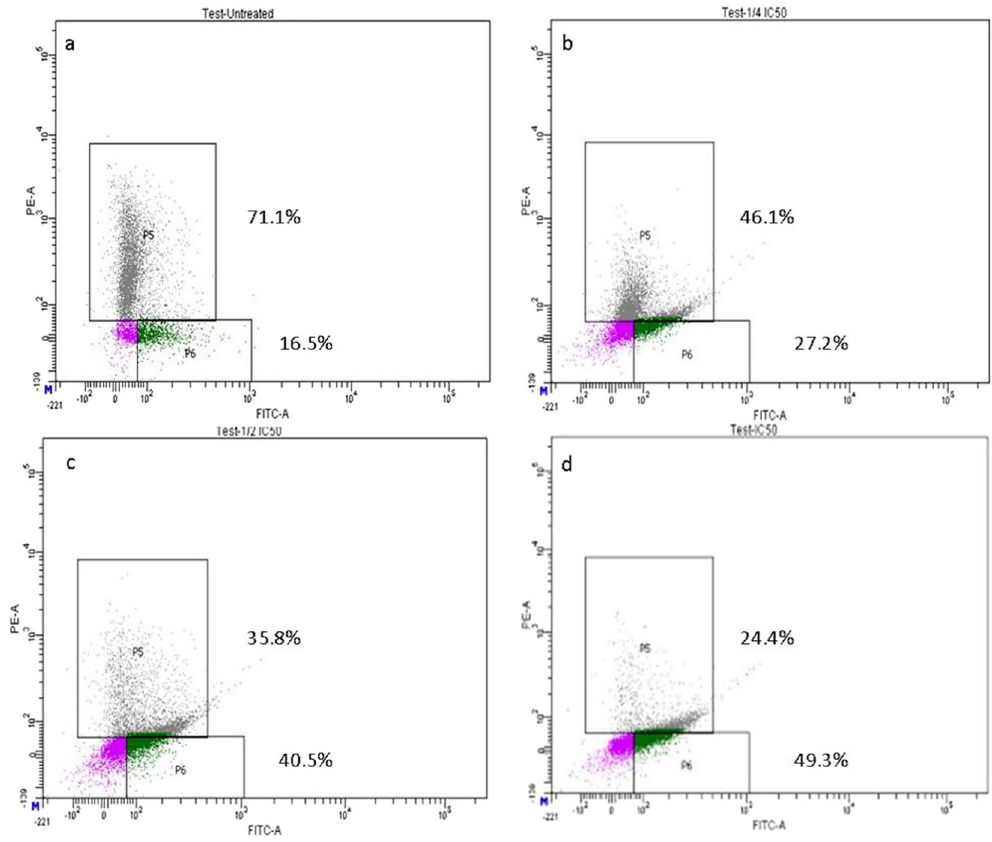
Figure 9. Mitochondrial depolarisation initiated by CPT-CEF. As analysed with JC-1 dye and flow cytometry, CPT-CEF treatments of HT29 cells with concentrations of ¼ IC 50 (panel b), ½ IC 50 (panel c), IC 50 (panel d), or untreated (panel a) for 48 h are